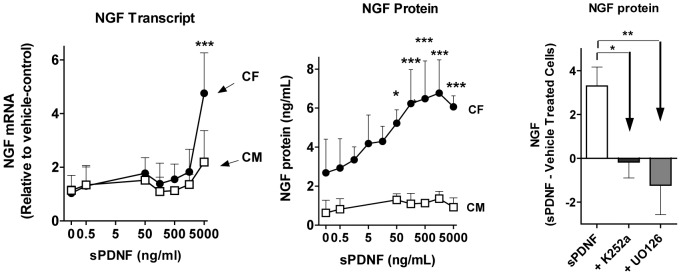
The T cruzi Trk-ligand sPDNF preferentially upregulates NGF in cardiac fibroblasts requiring TrkA signaling.
Left panel: sPDNF upregulates NGF transcripts in cardiac fibroblasts. Primary cultures of cardiac fibroblasts (CFs) and cardiomyocytes (CMs) were stimulated with the indicated concentrations of recombinant sPDNF for 3 h and their NGF transcript measured by qPCR. Middle panel: sPDNF upregulates NGF protein in cardiac fibroblasts. Cultures of CFs and CMs were stimulated with the indicated concentrations of sPDNF for 3 h and their culture overlays assessed for NGF by ELISA. Data are combined from three independent experiments; * P<0.05, *** P<0.001. Right panel: An inhibitor of TrkA autophosphorylation and another of TrkA downstream signaling block sPDNF-induced NGF upregulation in cardiac fibroblasts. Primary cardiac fibroblasts (triplicate wells) were pretreated for 30 min with vehicle or with TrkA autophosphorylation inhibitor K252a (500 nmol/L), or with the Erk kinase signaling inhibitor UO126 (10 µmol/L) (+K252a and U0126, respectively) and then with vehicle or sPDNF (500 ng/mL) for 24 h; NGF was measured in culture supernatants by ELISA, results are mean + s.d. and represent the difference between sPDNF and vehicle treated cardiac fibroblasts; * P<0.05, ** P<0.01.